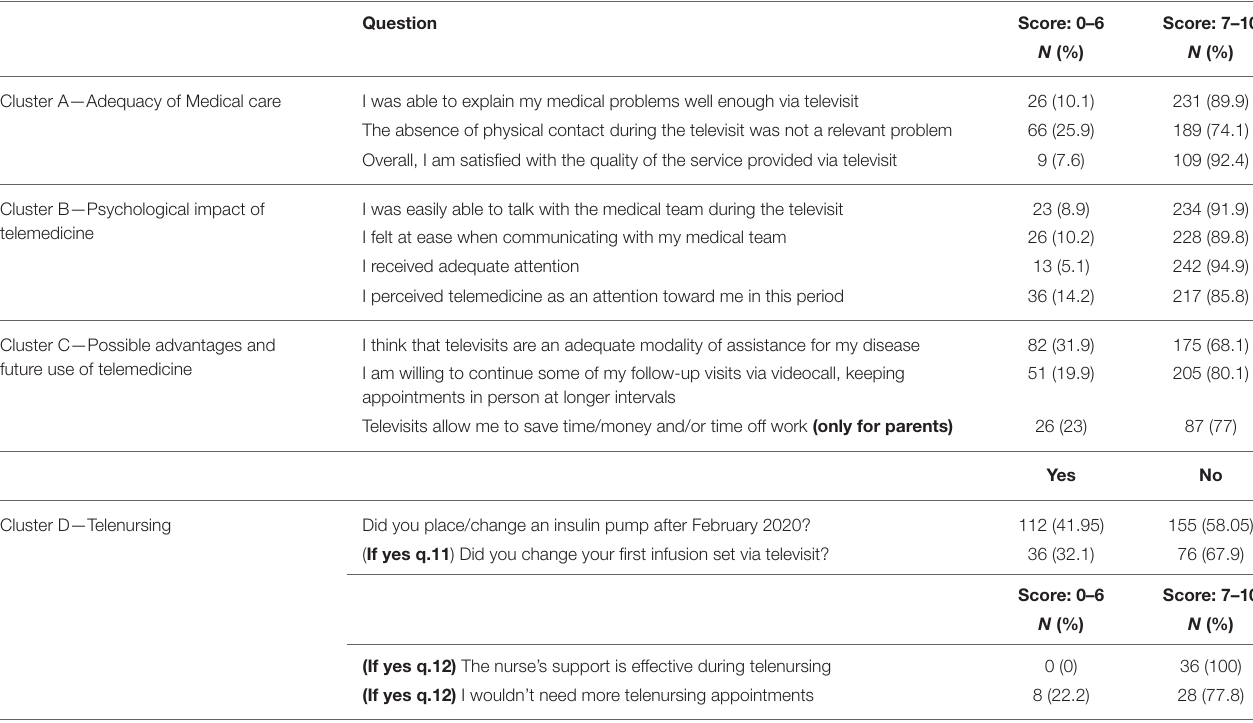
TABLE 1 | Survey—second part: evaluation of satisfaction.